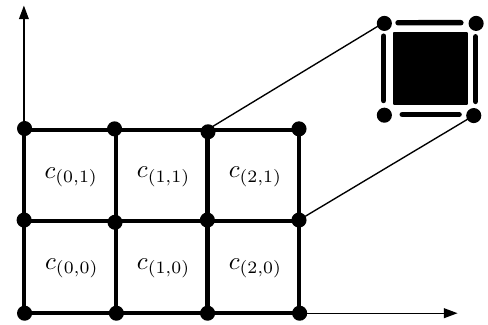
Figure 4: The valuations of two clocks are partitioned into 6 squares, 17 edges, and 12 vertices.